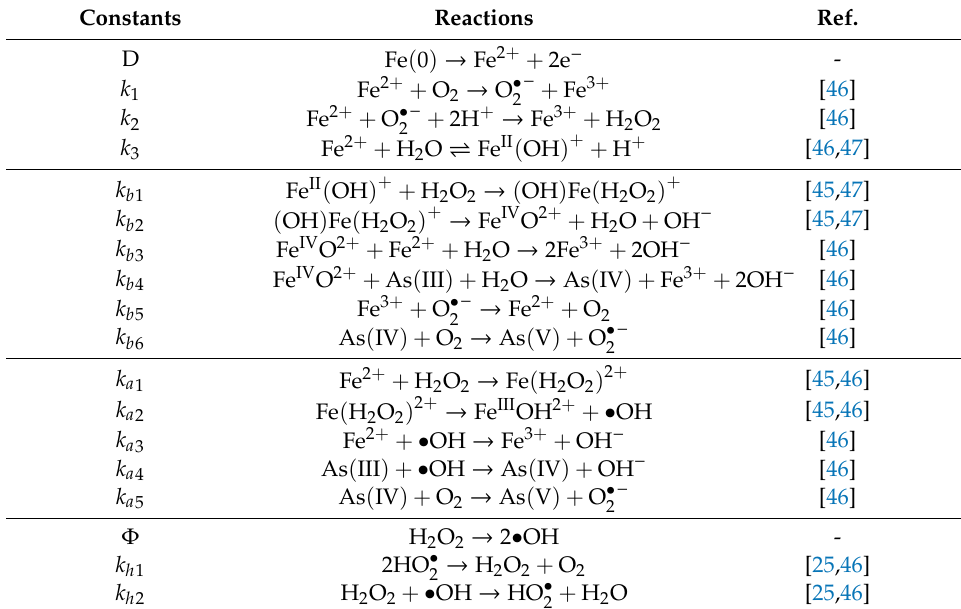
Table 2. Relevant reaction scheme involved in advanced EC